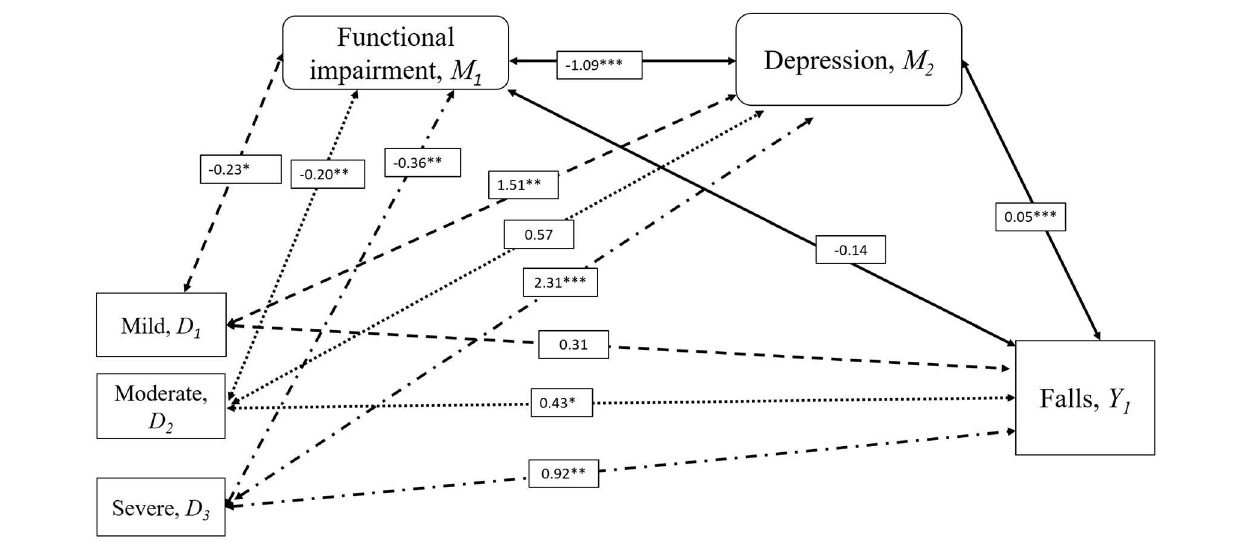
FIGURE 1 | Mediation Analysis for the Influence of Depression on Falls and Knee Pain Severity. Serial multiple mediation analysis with bootstrapping compared to severity of knee pain with falls risk adjusted for age, sex, diabetes, incontinence, and visual impairment. Moderate (D 2 ) and severe knee pain (D 3 ) was associated with a history of falls in the past 12 months (Y 1 ), but not mild knee pain (D 1 ) compared to the individuals with no knee pain. Increased risk of falls in moderate and severe knee pain were mediated by depression (M 2 ) resulting from functional impairment (M 1 ). Significance indicated by * p < 0.05, ** p < 0.01, *** p < 0.001. Numbers were standardized β coefficients. IADL scores were used to represent functional